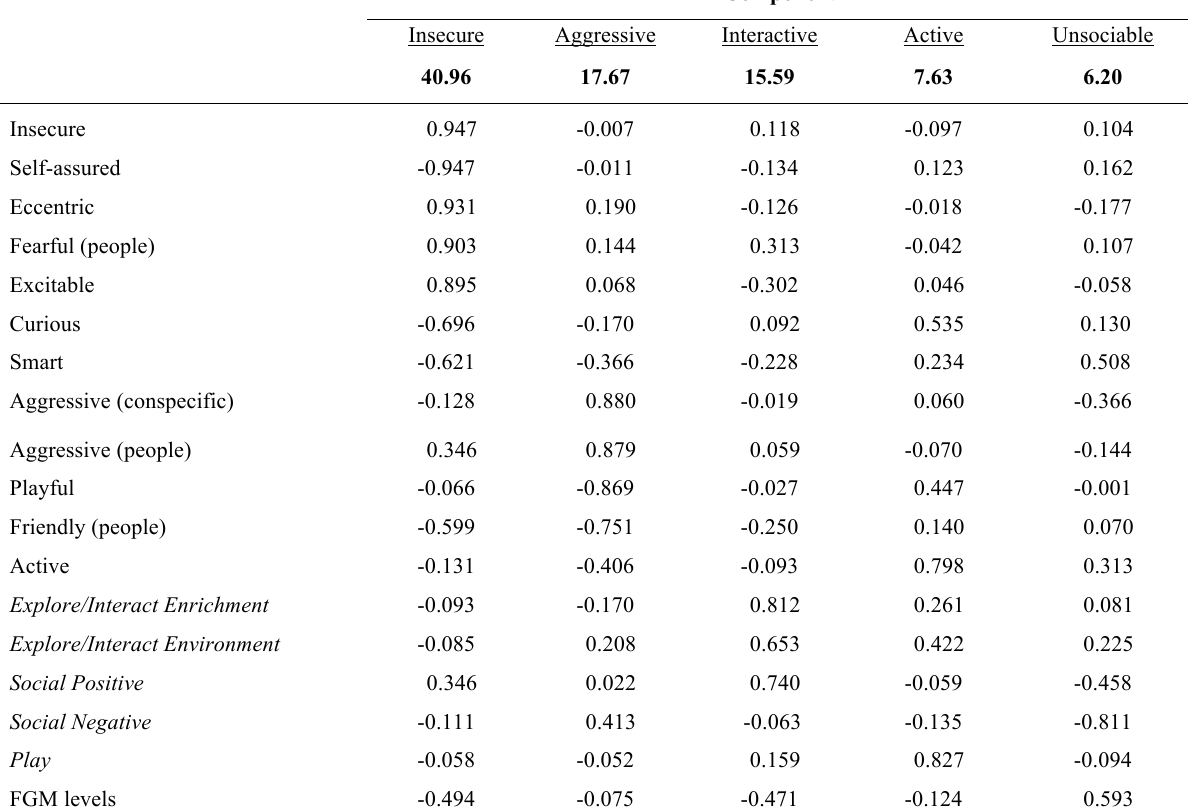
Factor Loadings of Personality Component Analysis (PCA) with Varimax Rotation and Kaiser Normalization